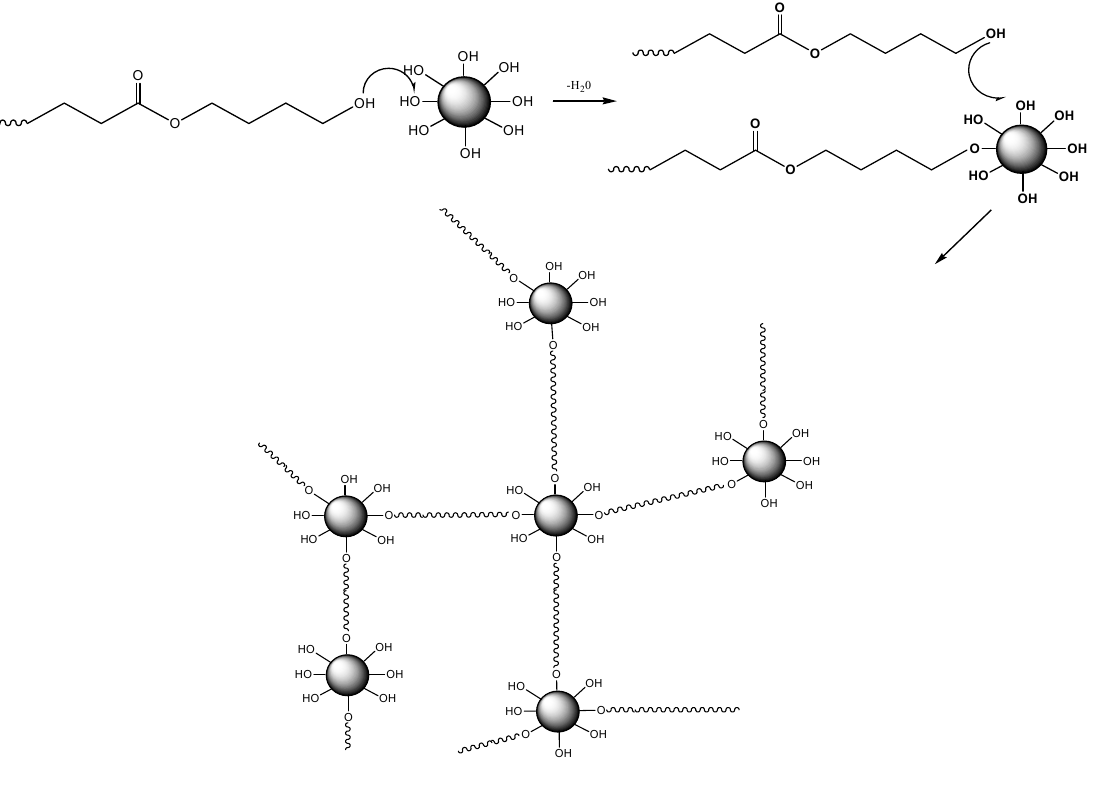
Figure 12. Cross-linked structures obtained by reaction between the hydroxyl end groups of PBS and the surface silanol groups of fumed silica